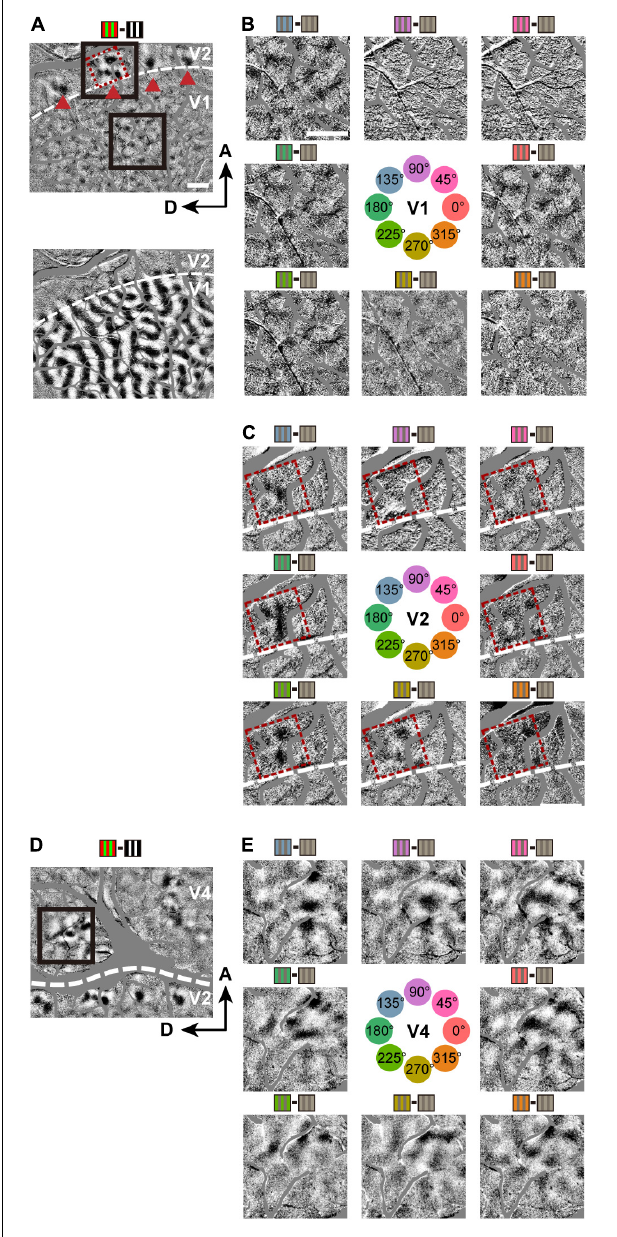
FIGURE 2 | Hue maps in V1, V2, and V4. (A) Top: a subtraction map in response to isoluminant red/green minus luminance-contrast (100%) black/white grating stimuli (including V1 and V2 in Case 1), visualizing color-sensitive regions. Red dashed frames highlight a hue-sensitive region in V2. Triangles indicate the same four color-sensitive regions in V2 for both (B,C) ; Bottom: A subtraction map in response to left eye minus right eye stimulations, determining the border between V1 and V2 (broken line). (B) Subtraction maps in response to individual hue minus achromatic grating stimuli, from the V1 region outlined by a lower black frame in the top panel of (A) . The hues used for the stimuli are indicated at the center. (C) Subtraction maps in response to individual hue minus achromatic grating stimuli, from a V2 region outlined by a upper black frame in the top panel of (A) . (D) A subtraction map in response to red/green minus black/white grating stimuli (including V2 and V4 in Case 1). (E) Same conventions as in (B) , but from a V4 region outlined by the black frame in (D)